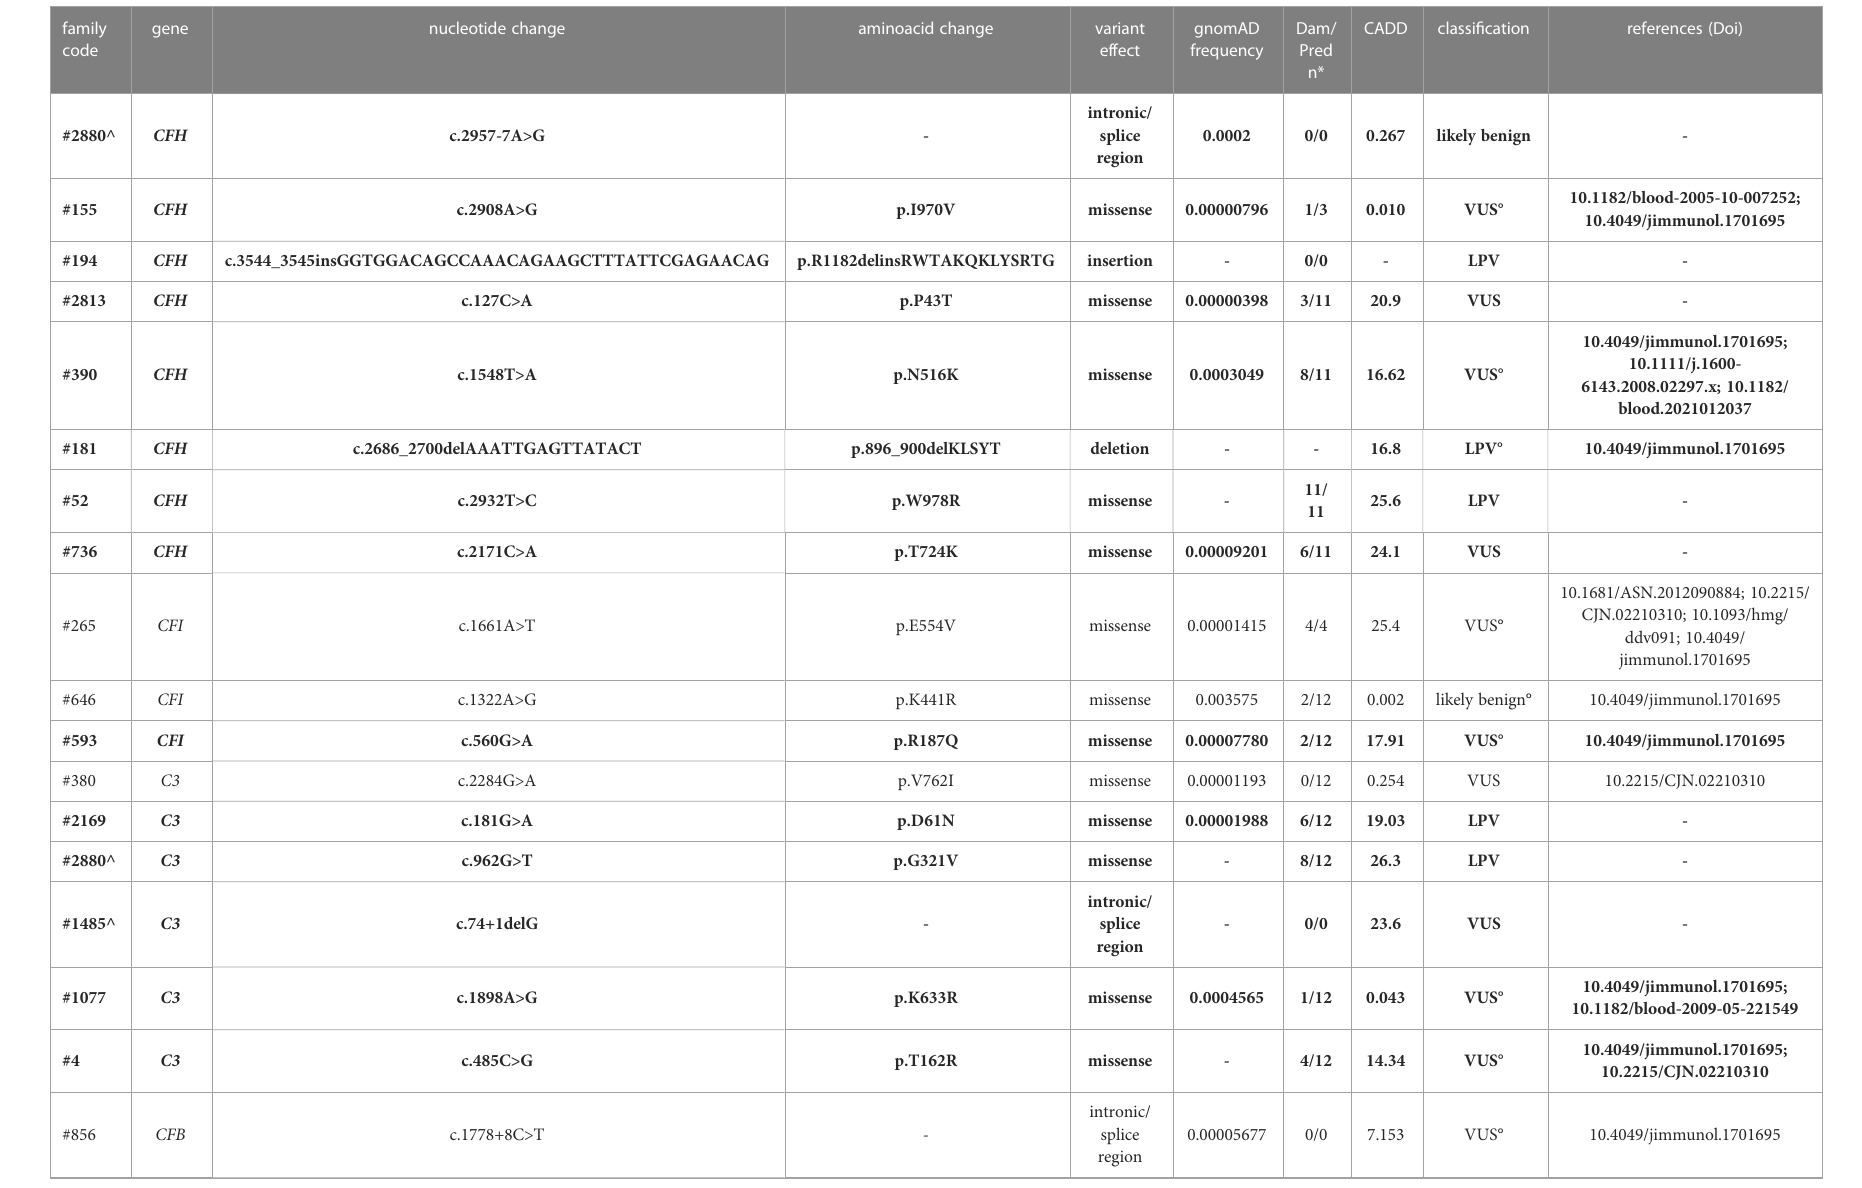
TABLE 2A List of rare likely pathogenetic variants (LPV), variants of uncertain signi fi cance (VUS) and benign and likely benign variants in genes encoding soluble proteins and identi fi ed in aHUS